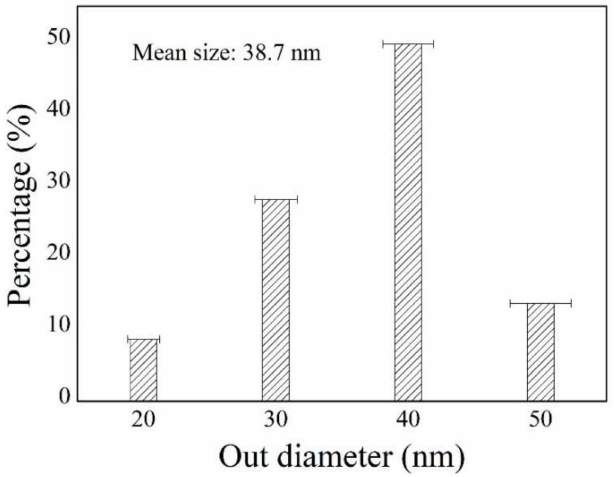
Figure 2. The diameter distribution of the CNTs in the mullite-CNT composite membrane.